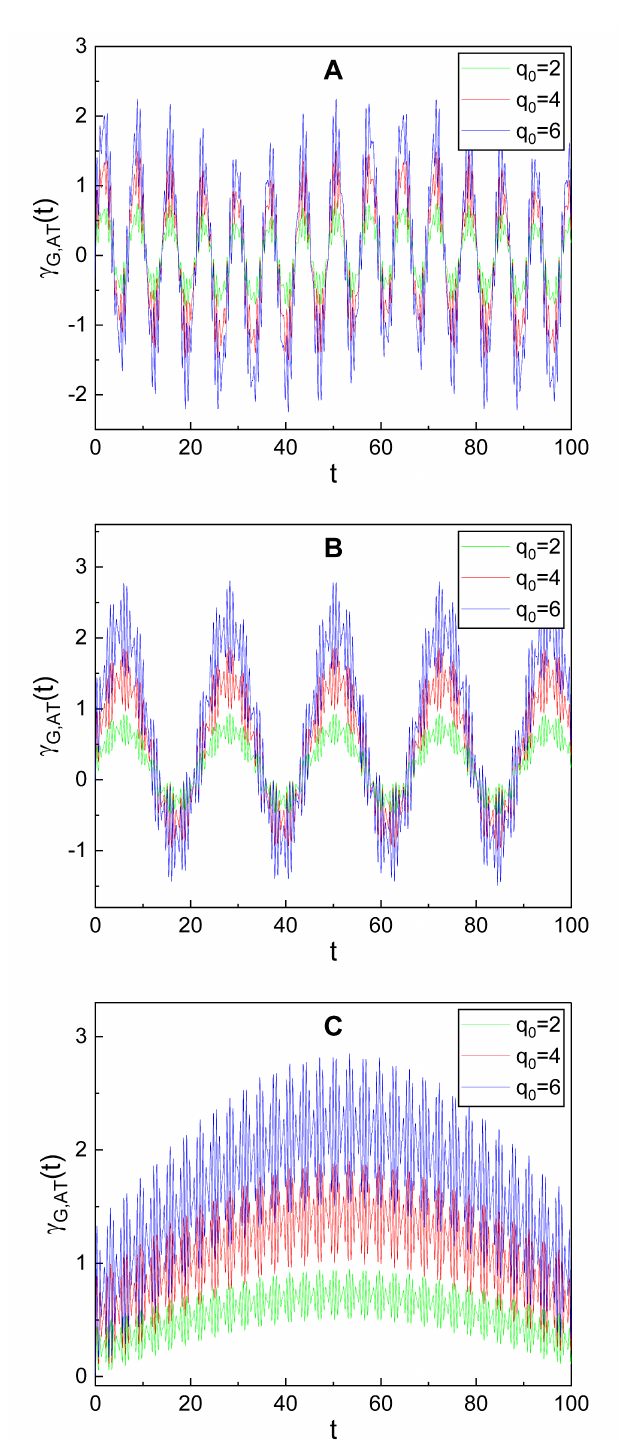
Figure 4. Temporal evolution of the additional term, γ G ,AT ( t ) , of the geometric phase (Equation (25)) for several different values of q 0 . We used ω 2 = 0.90 for ( A ), ω 2 = 0.28 for ( B ), and ω 2 = 0.03 for ( C ). Other values used in the plot are common and they are given by ω 1 = 1, ξ 0 = 1, λ = 0, ω = 10, ϕ = θ = 0, γ 0 = 0, α 0 = 5, p 0 = 5, c 1 = c 2 = 0.05, (cid:101) = 1, and ¯ h = 1. All curves show novel geometric-phase oscillations associated with the one-photon